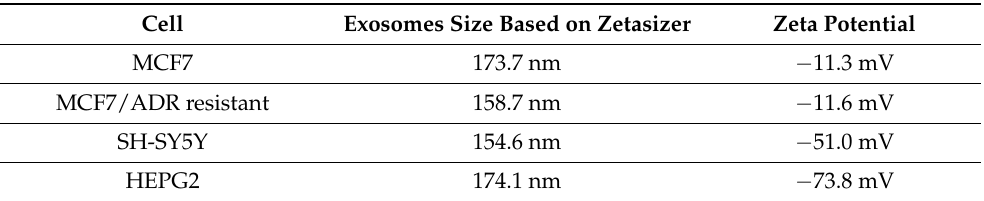
Table 1. The summary of the Zeta-sizer and Zeta potential peaks for the four exosomes isolated from MCF7, MCF7/ADR, SH-SY5Y, and HEPG2. Cell